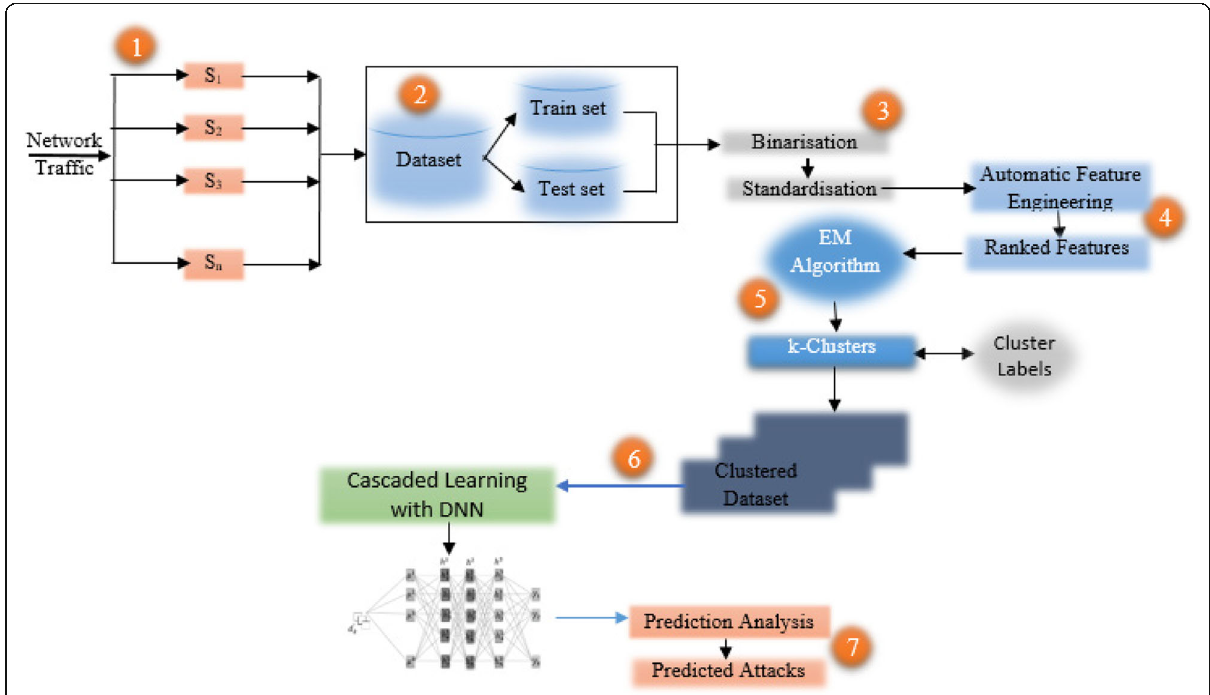
Fig. 1 Architecture of the Proposed Deep Learning